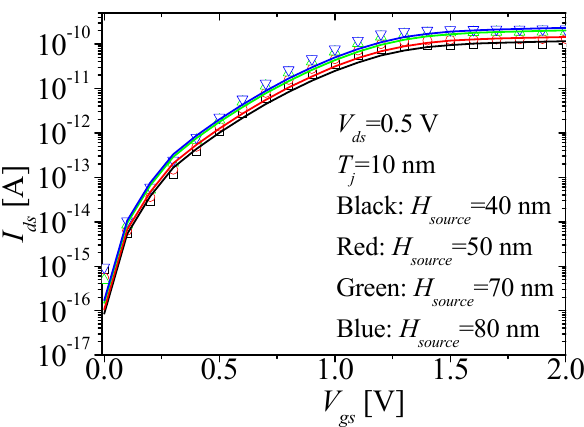
Figure 7. I ds from TCAD (symbols) versus I ds calculated by the model for an LTFET with T j = 10 nm, and different H source = 40 nm (black), 50 nm (red), 70 nm (green) and 80 nm (blue) at V ds = 0.5 V.